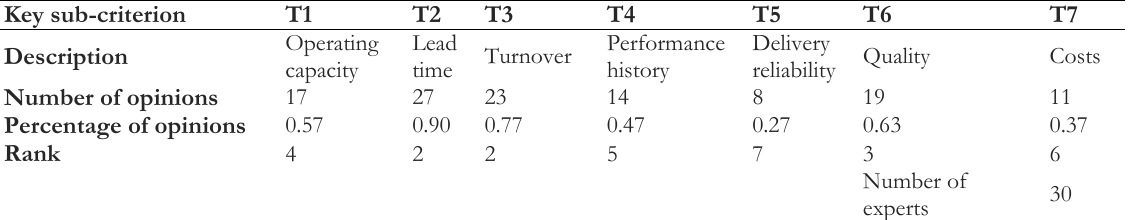
Table 6. Percentage of opinions and rank of each sub-criterion.